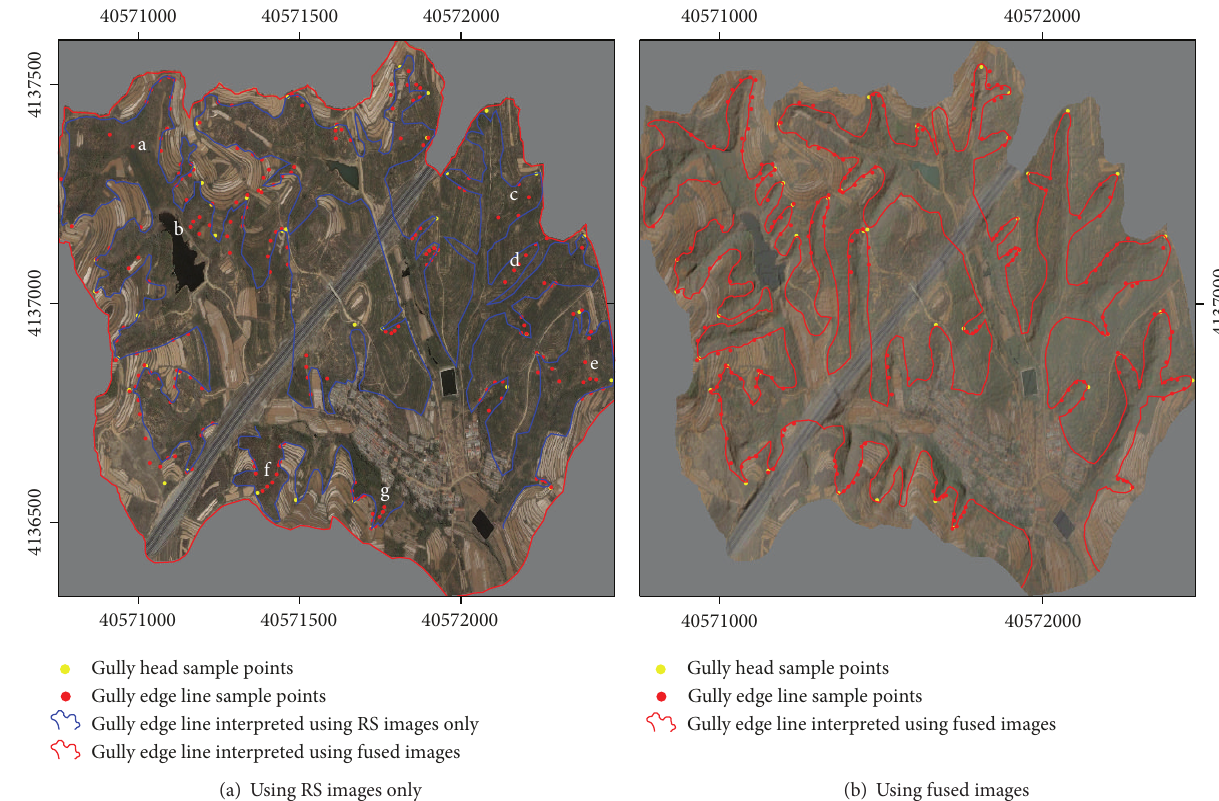
Figure 4: Gully edge lines interpreted and points field measured along gully head and gully